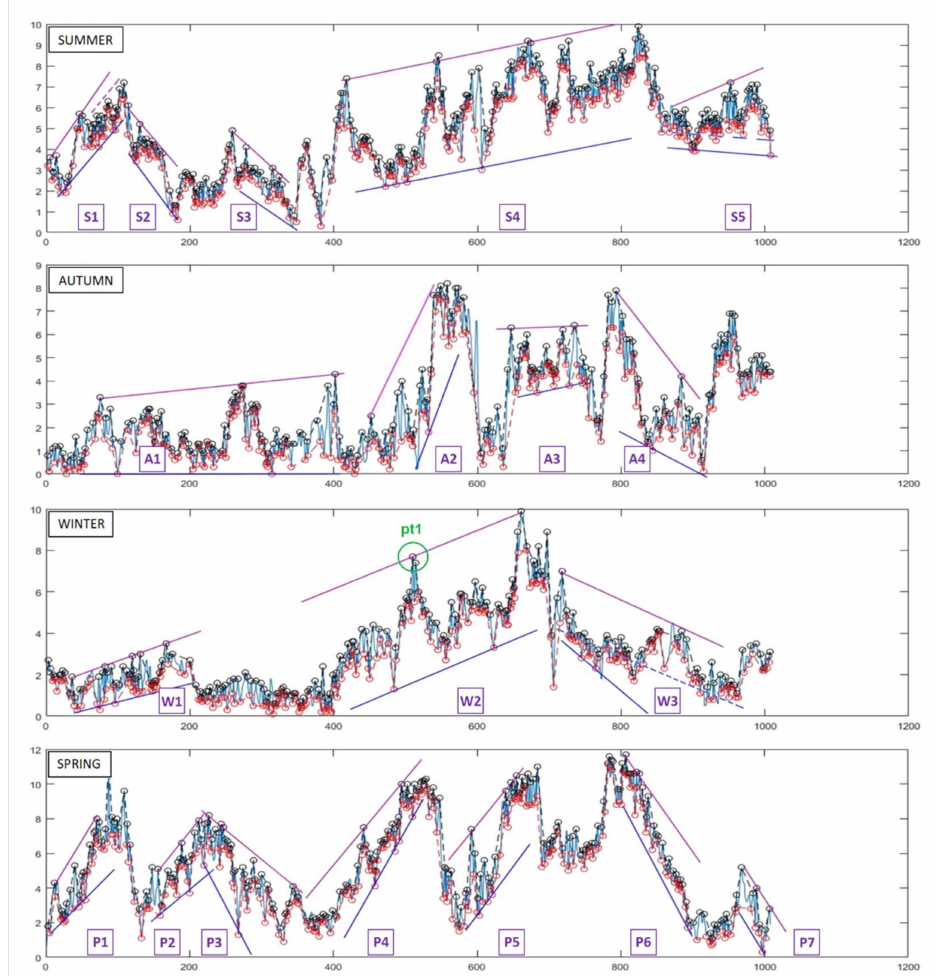
Figure 1. Wind speed data series for Los Montes del Cierzo (10 min resolution, for the first weeks of August 2016, November 2016, January 2017 and April 2017, height 10 m above the ground) with some significant examples of support and resistance